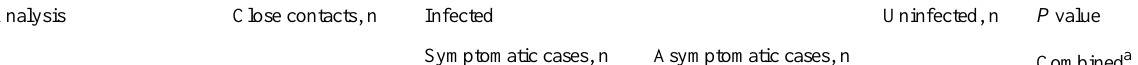
Table 2. Analysis of the transmission rates through close contacts by the symptomatic and asymptomatic cases of the coronavirus disease in Ningbo after removing all the cases associated with the super-spreader.